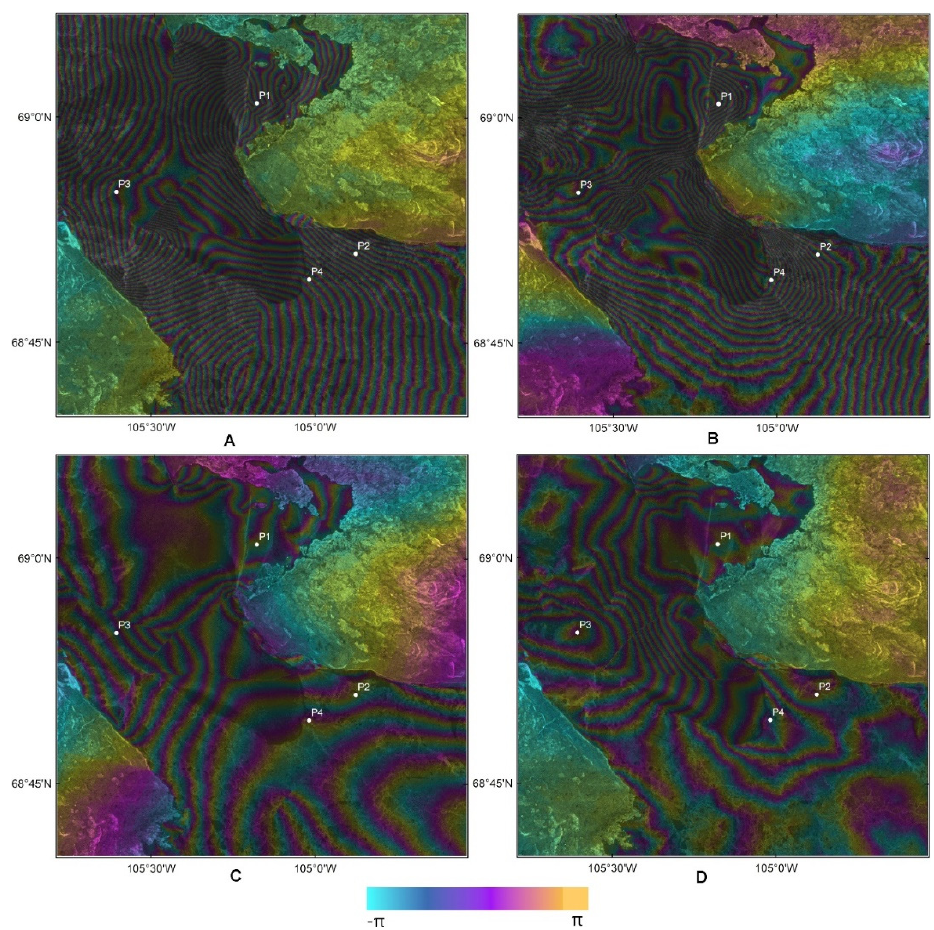
Figure 5. Interferograms from descending Sentinel-1A of HH polarization ( A ): 17 February–1 March, ( B ): 1–13 March, ( C ): 13–25 March, ( D ): 25 March–6 April. One cycle of color ( −π to π ) representing 2.8 cm in range change.